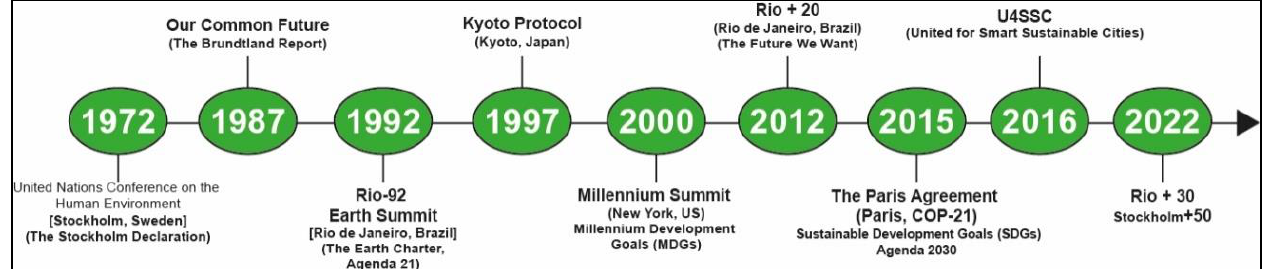
Figure 2. World summits and documents concerning the future we desire. Elaborated by the au- thor, based on [5]. based on